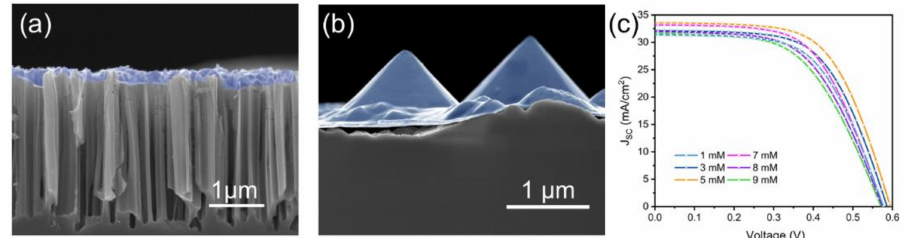
Figure 3. ( a , b ) SEM images of silicon nanowires and pyramids ( c ) J–V curves for the AgNO 3 treated Si-PNWs solar cells. Table 1. Photoelectric property parameters and AgNO 3